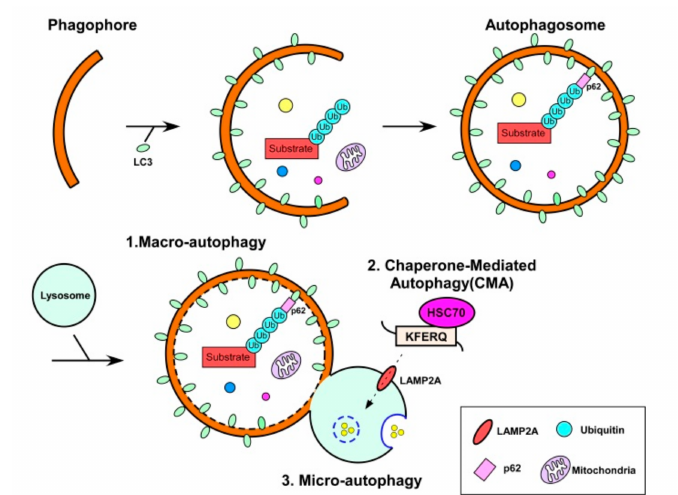
Figure 4. The autophagic degradation of proteins and organelles. Autophagy is the evolutionally conserved degradation pathway of intracellular components by the lysosomes. Autophagy involves initiation of the formation of the isolation membrane (phagophore), elongation of phagophore, maturation into autophagosome and fusion with lysosome for degradation. Three types of autophagy process have been described: macroautophagy (1), chaperone-mediated autophagy (CMA) (2), and microautophagy (3). The autophagosome biogenesis is executed by the sequential function of autophagy-related (Atg) proteins. Among Atg proteins, the formation and size of autophagosome are determined by two ubiquitin-like conjugation systems, the Atg12 and Atg8 / LC3 systems. The carboxyl-terminal of LC3 is cleaved by the Atg4 to form LC3-I. The final LC3 lipidation with phosphatidylethanolamine (PE) to form LC3-II are orchestrated by Atg7, Atg3, and a complex consisting of Atg12-Atg5-Atg16L serving as E1, E2 and E3-like enzyme. The deficiency of basal autophagy may result in the accumulation of the abnormal aggregates of misfolded proteins in skeletal muscle during